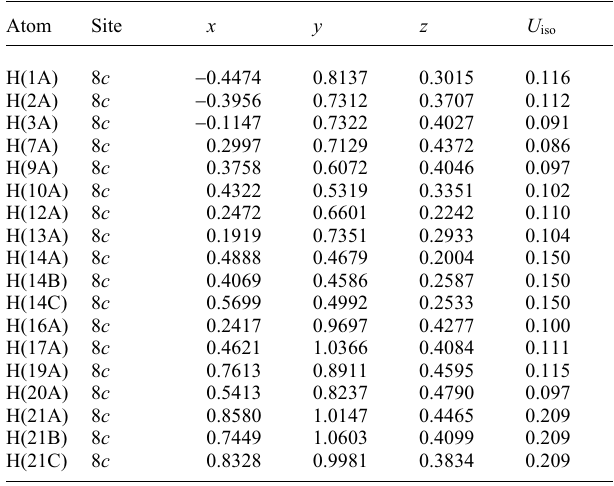
Table 2. Atomic coordinates and displacement parameters (in Å 2 )